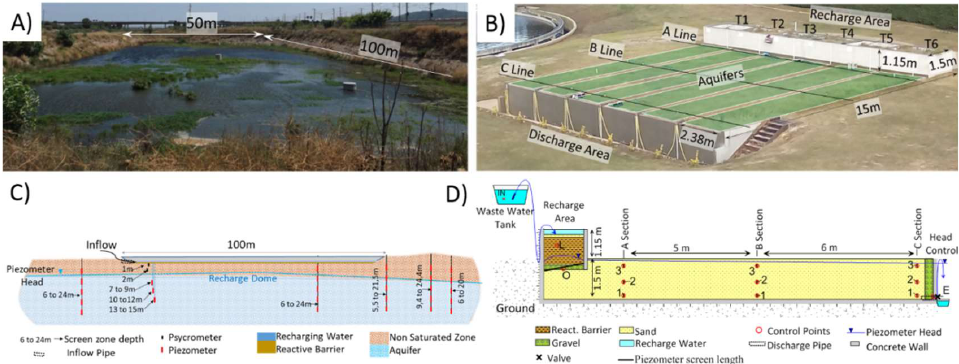
Figure 2. ( A) Sant Vicenç dels Horts infiltration basin, and ( C) the cross-section with the monitoring Figure 2. ( A ) Sant Vicenç dels Horts infiltration basin, and ( C ) the cross-section with the monitoring points and their screened sections; ( B ) six Palamós replicate MAR systems named T1 to T6, and ( D ) points and their screened sections; ( B ) six Palam ó s replicate MAR systems named T1 to T6, the cross-section of one generic replicate. Flow direction is from left to right in both cross-sections. and( D )thecross-sectionofonegenericreplicate.